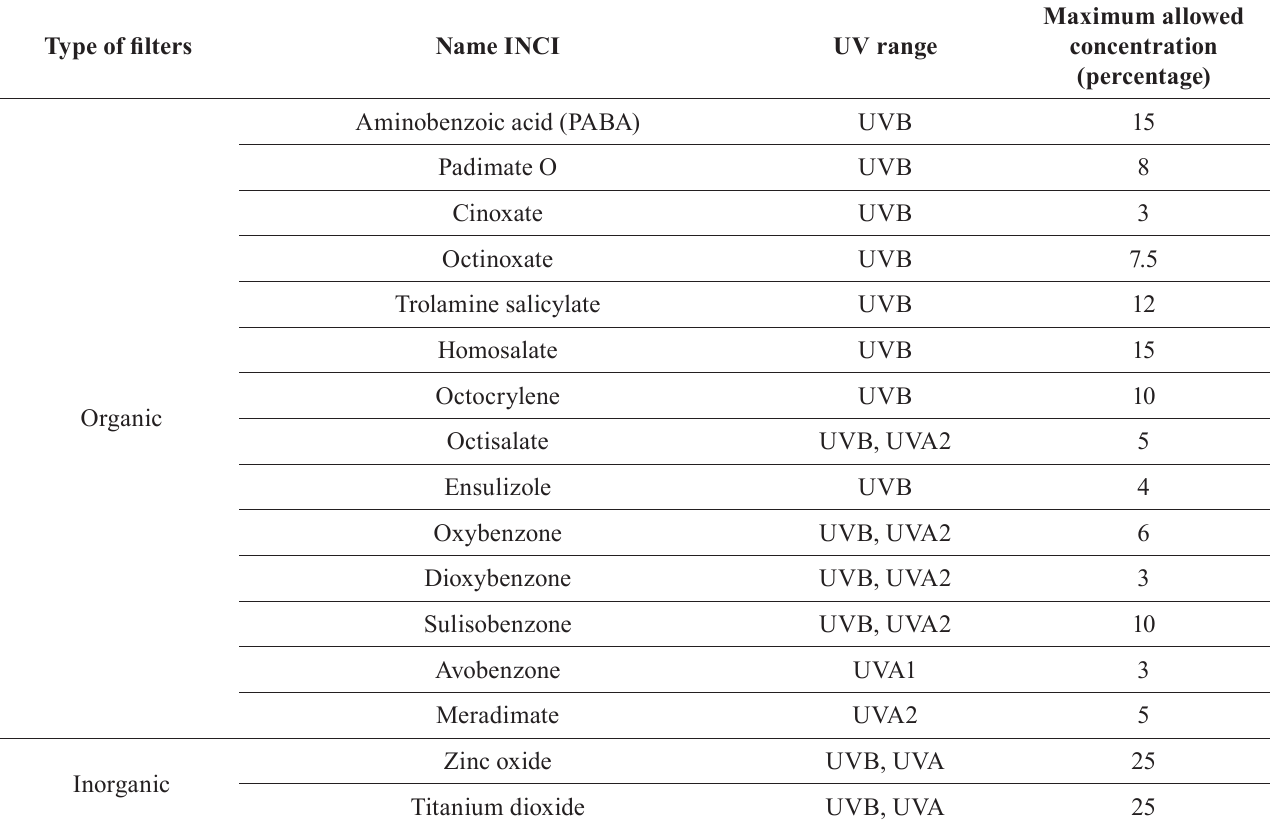
Table 1. Al lowed Ultraviolet filters listed in the US Food and Drug Administration.